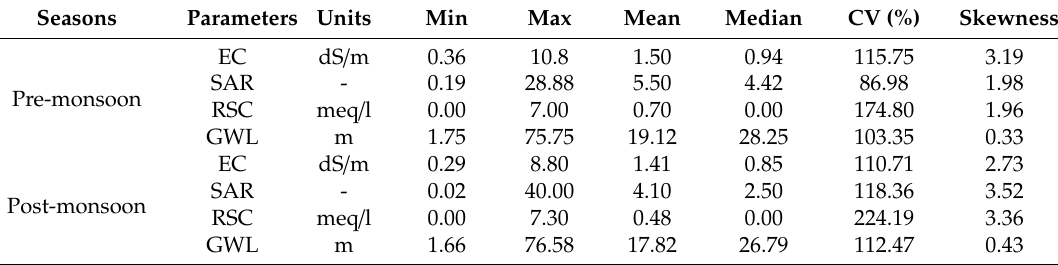
Table 2. The statistical summary of groundwater properties in 2016 ( n =